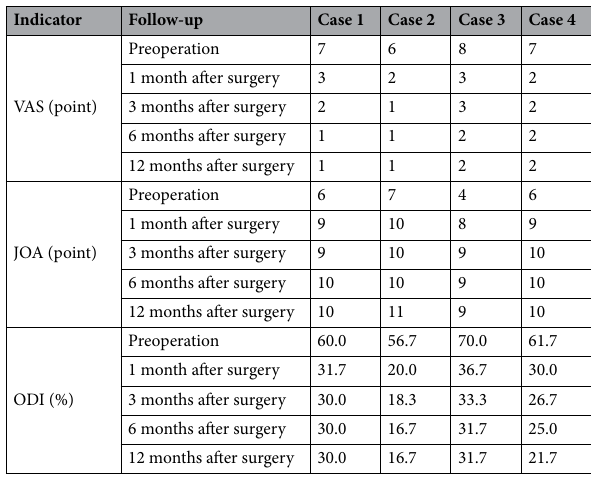
Table 2. Preoperative and postoperative VAS, JOA, and ODI scores of four cases.